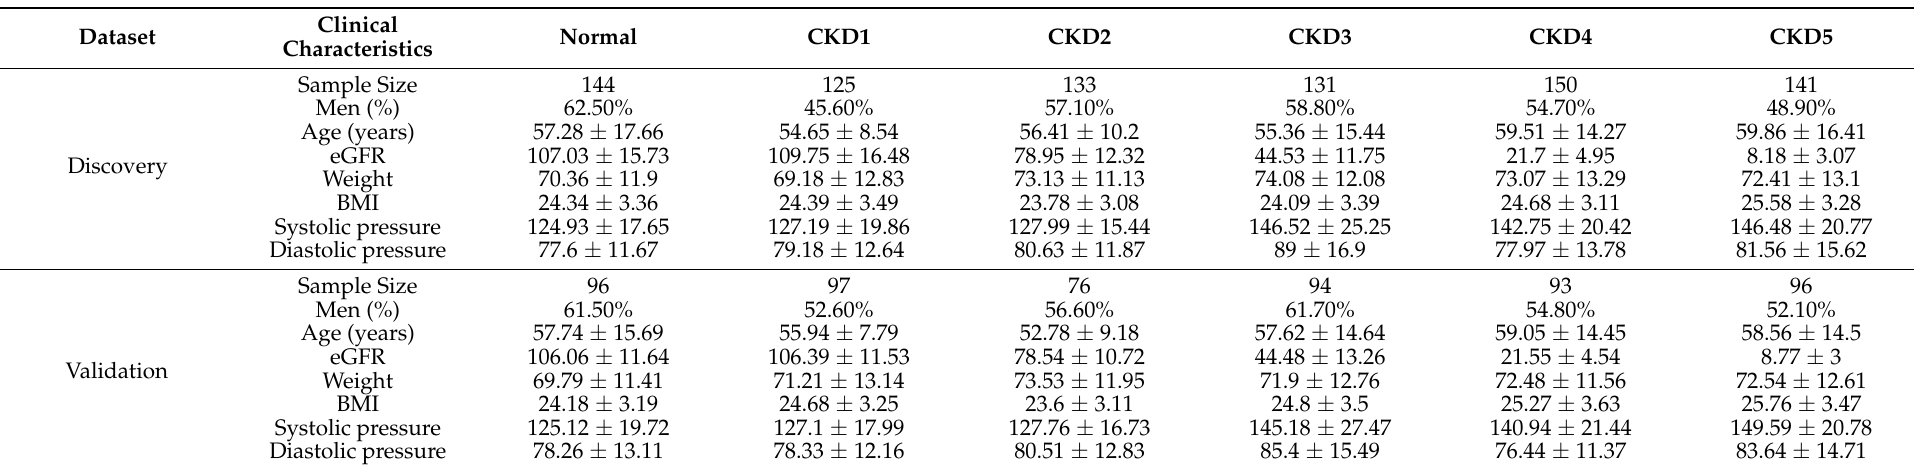
Table 1. Sample descriptions and basic clinical measurements.